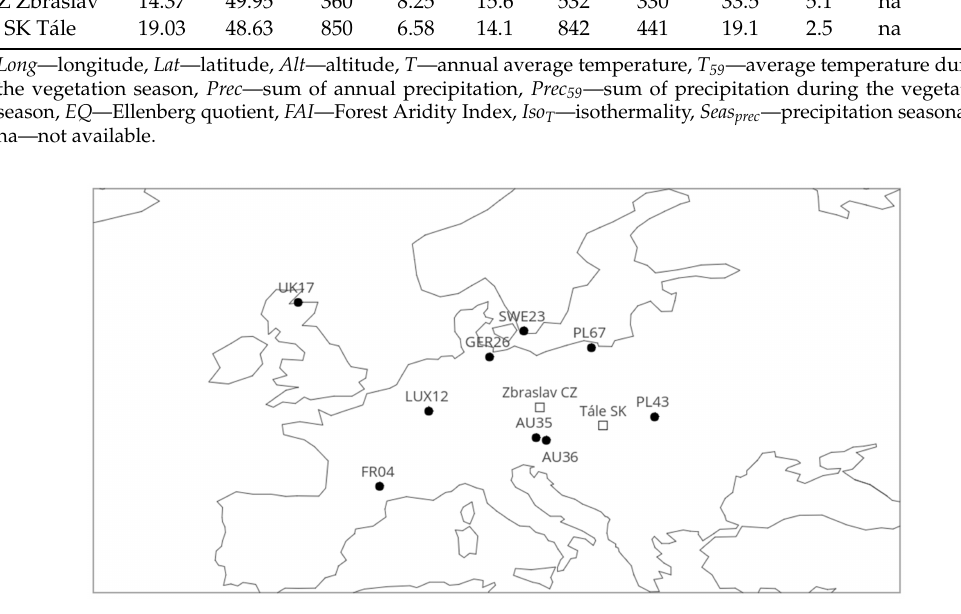
Figure 1. Localities of the tested provenances (dots) and provenance plots